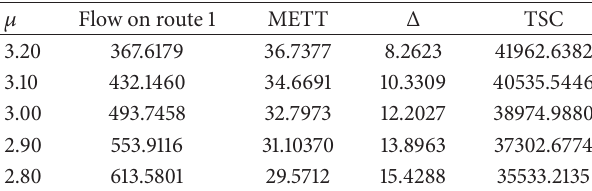
Table 6: Results with different 𝜇 at METE.